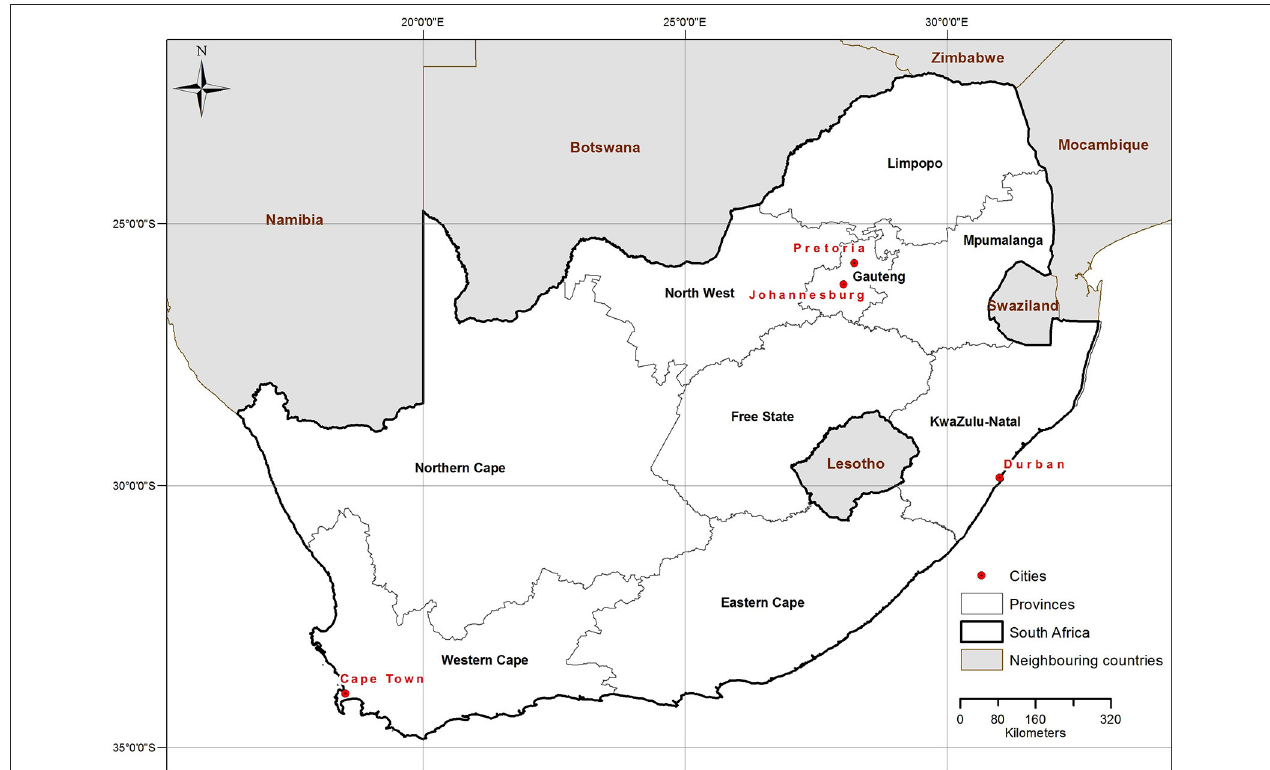
FIGURE 1 | Map of South Africa indicating the nine provinces and the four major